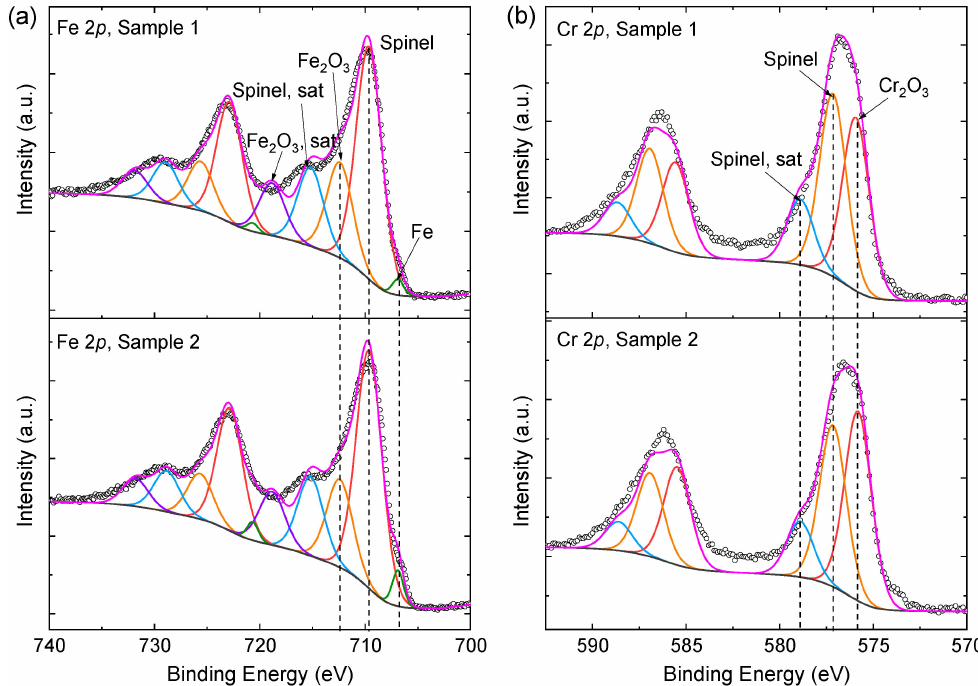
Figure 3. XPS spectra of the steel samples after laser processing. ( a ) Fe 2 p spectra; ( b ) Cr 2 p spectra. The identified species were marked for 2 p 3/2